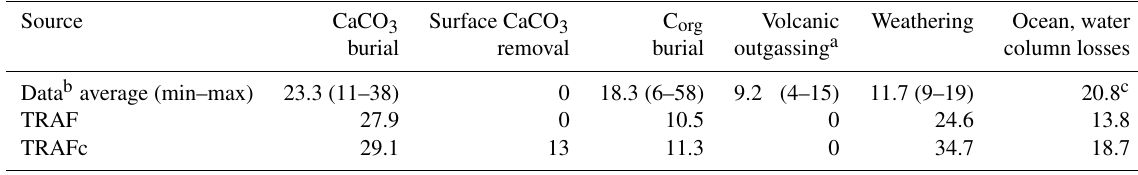
Table 2. Model–data comparison of average carbon fluxes from 6000BCE to 1850CE (Tmolyr − 1 ).